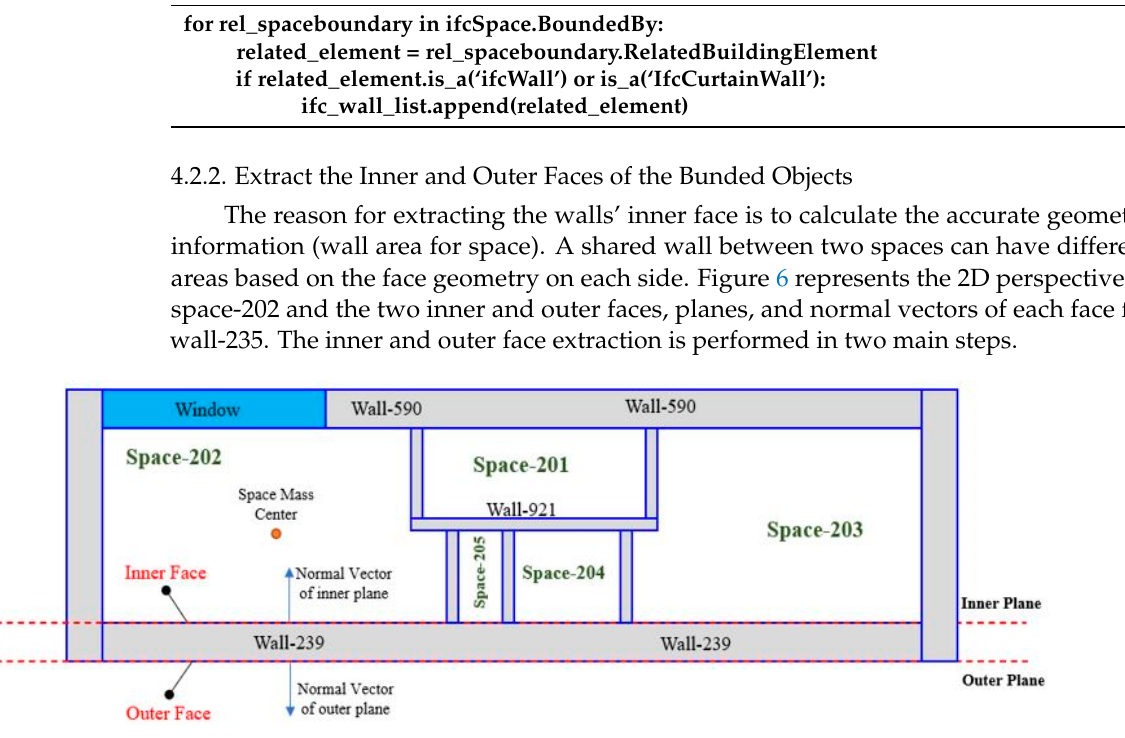
Table 3. Extracting the space’s bounded walls using the semantic query. Pseudo Code